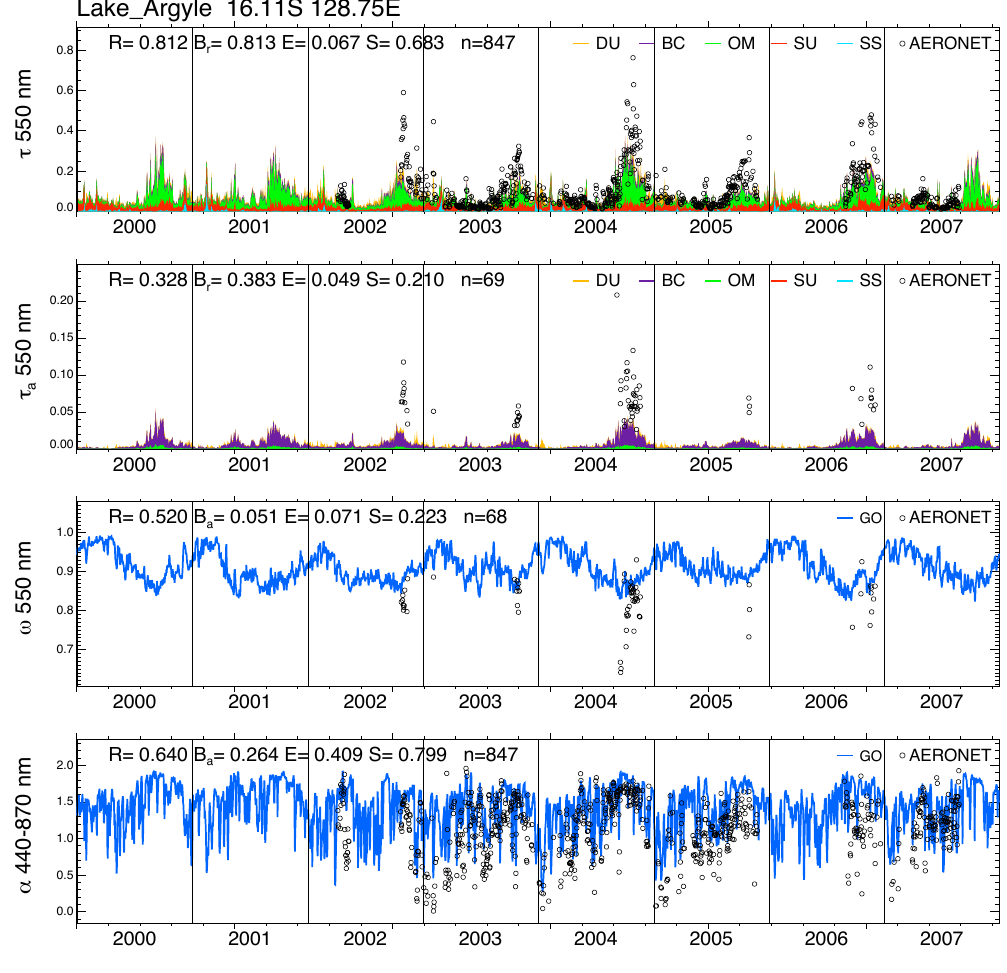
Fig. 5h. Same as Fig. 5a but for Lake Argyle in